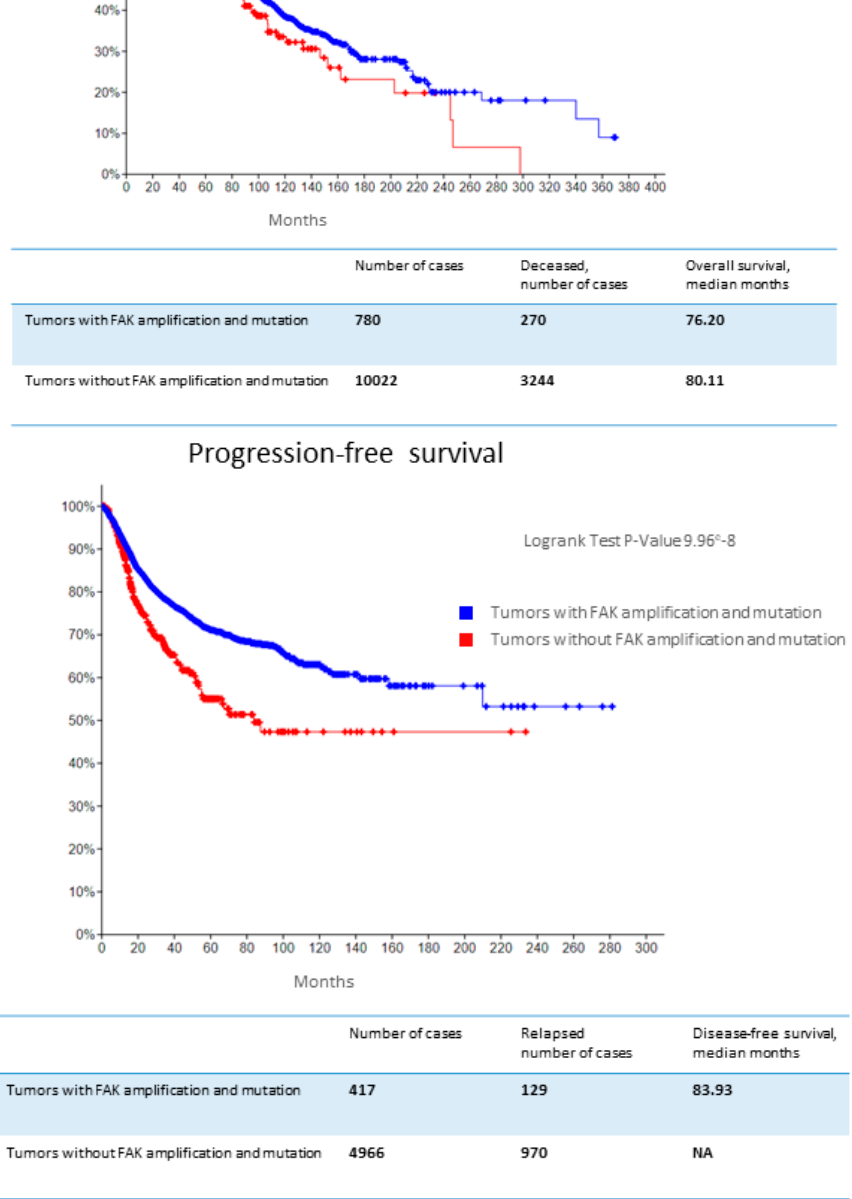
Figure 5. Association of focal adhesion kinase ( FAK ) amplification with survival. Kaplan-Meier overall survival and progression-free survival analysis of patients with versus without FAK amplification in their tumors (many different cancers included) in The Cancer Genome Atlas (TCGA) database [110].